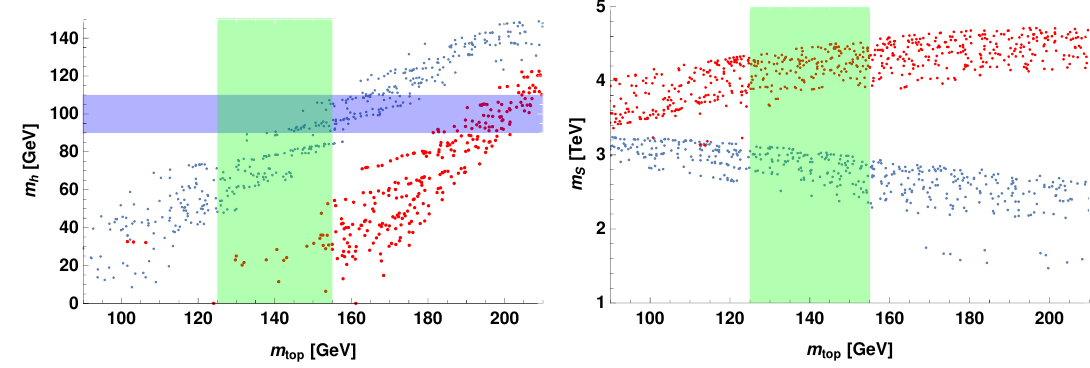
Figure 6 . Left panel: the Higgs mass as a function of the top quark mass for 1 /R 0 = 10 TeV. Points in red feature M ˜ u > 0 and predict the wrong Higgs mass while the points in blue belong to M ˜ u < 0 and are compatible with the correct Higgs mass. Right panel: the mass of the colored scalar versus the top quark mass. Points in red (blue) feature M ˜ u > 0 ( M ˜ u < 0